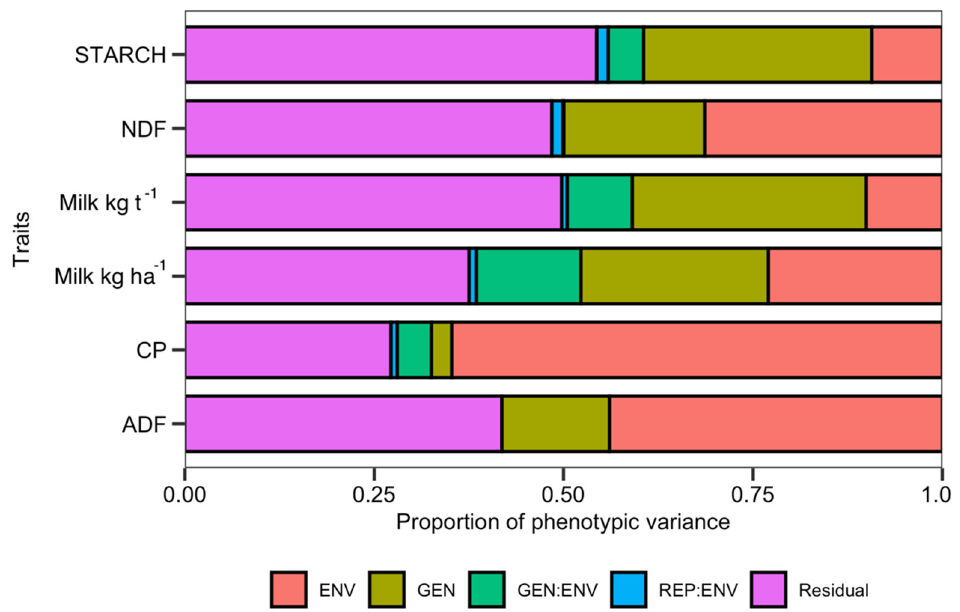
Figure 2. Distribution of variance components per trait.